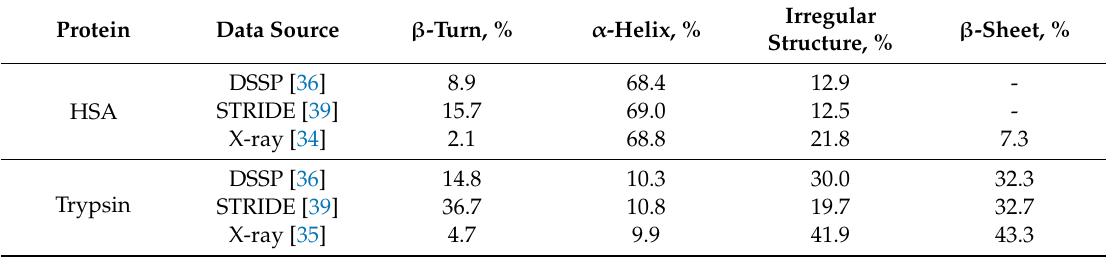
Table 3. The HSA and trypsin secondary structure.